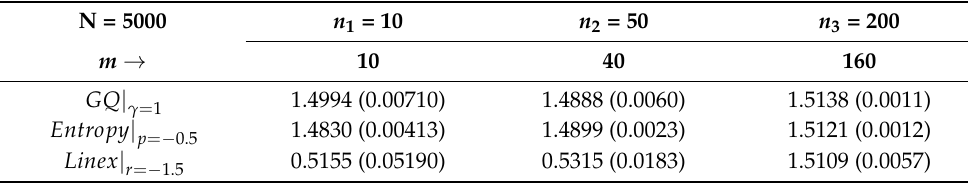
Table 10. Bayesian estimators and PR (in brackets) under the three loss functions.